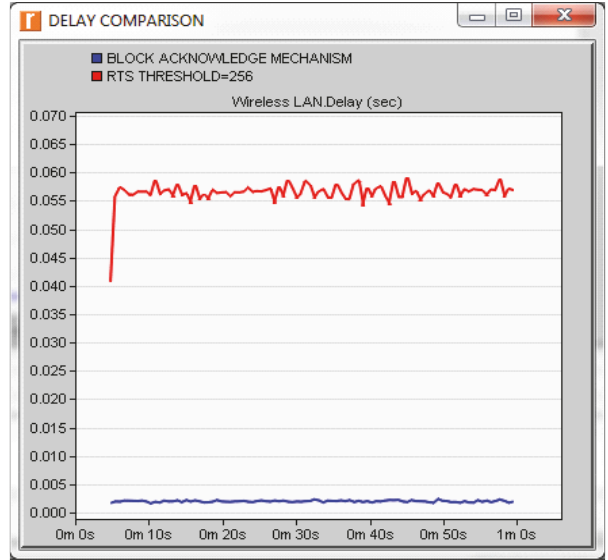
Figure 9: WLAN delay comparison for block acknowledgement versus RTS